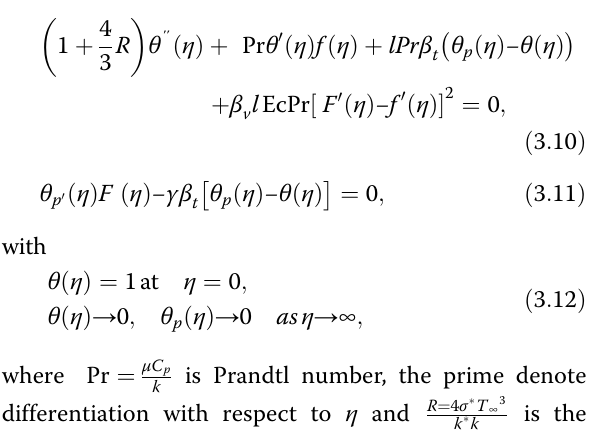
h i ffiffiffiffiffiffiffi p Re C f and − Nu x for different Re 1 = 2 Using (3.9) into (3.7) and (3.2), one can get the following non-linear ordinary differential equations: